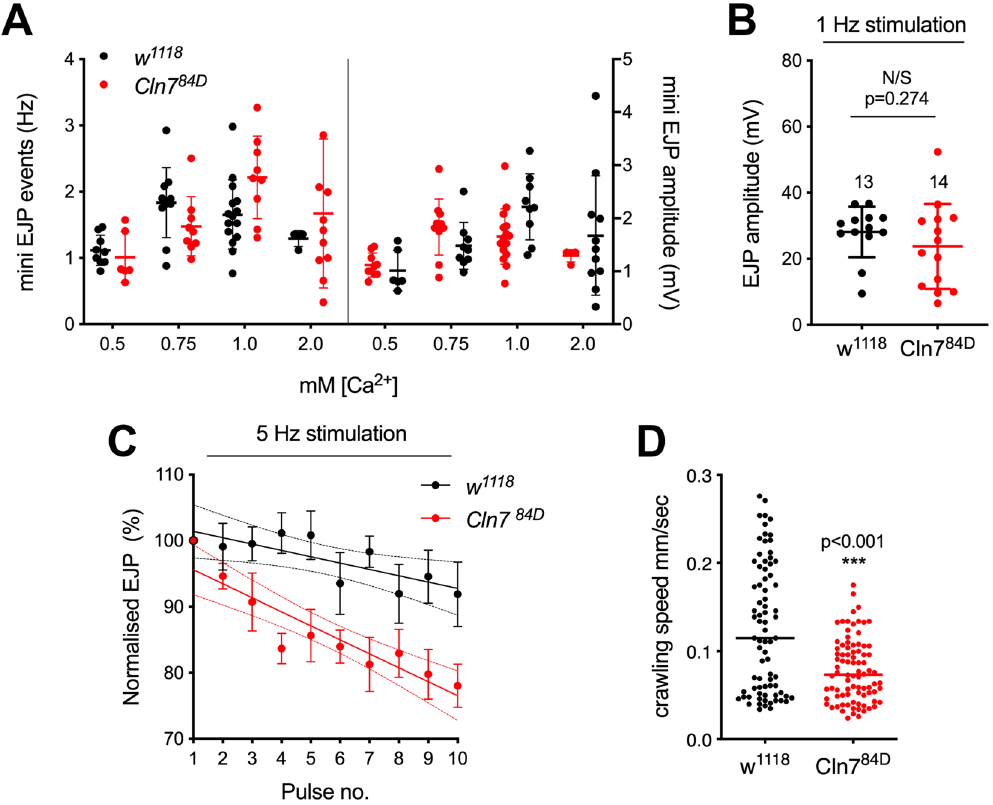
Figure 4. Altered neural function in Cln7 mutant flies. ( A–C ) Electrophysiological recordings from muscle 4 in w 1118 control and Cln7 84D larvae. ( A ) The frequency ( A ) and amplitude ( B ) of miniature excitatory junction potentials (mEJP) are not significantly changed in Cln7 larvae. mEJP frequency (left) was calculated over 120 s for each larva and amplitude (right) from 201–835 events using four different concentrations of extracellular Ca 2 + . Mean is indicated by a solid bar; error bars indicate SD. 2-way ANOVA with Sidak’s multiple comparisons. F = 0.6086; DFn = 1; DFd = 66; p = 0.4381 for both. ( B ) Excitatory junction potentials (EJPs) are unchanged in Cln7 larvae. The mean of 16 EJPs at 1 Hz was calculated from n = 13 ( w 1118 ) or 14 ( Cln7 84D ) in 1 mM Ca 2 + . Mean is indicated by a solid line; error bars show SD. p = 0.274; Mann-Whitney. ( C ) Cln7 mutant synapses display an increased rate of fatigue at 5 Hz stimulation. EJP amplitude at 5 Hz was normalized to the mean amplitude at 1 Hz stimulation immediately beforehand. n = 4 NMJs for w 1118 and = 6 for Cln7 84D . Trend lines fitted by linear regression are shown with solid lines with 95% confidence intervals indicated by dashes. R 2 : w 1118 = 0.149; Cln7 84D = 0.383. The slopes are significantly different: F = 4.786; DFn = 1; DFd = 96; p = 0.0311, t-test. ( D ) Crawling speed is reduced in Cln7 84D larvae. Mean speed of w 1118 control (n = 109) and Cln7 84D (n = 86) larvae was determined at 2.5 fps over 5 mins. **** p < 0.0001;